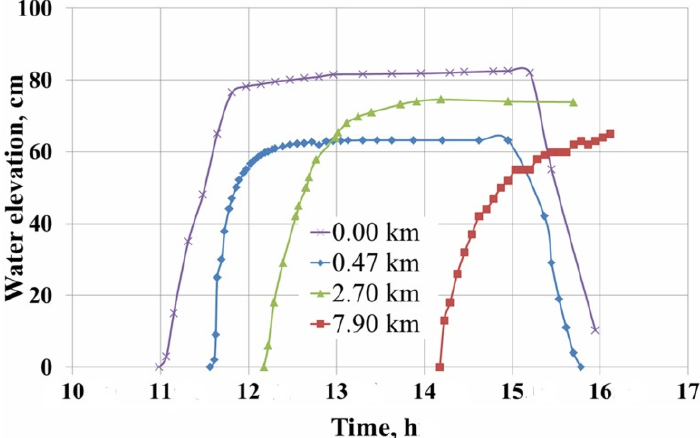
Figure 11. Stage hydrographs at different distances of the release of turbine water at Angiriai SHP. 18 August 2009, on the Susve River. Two turbines were started at a full capacity and shut down after 3 h. (Elevation not to